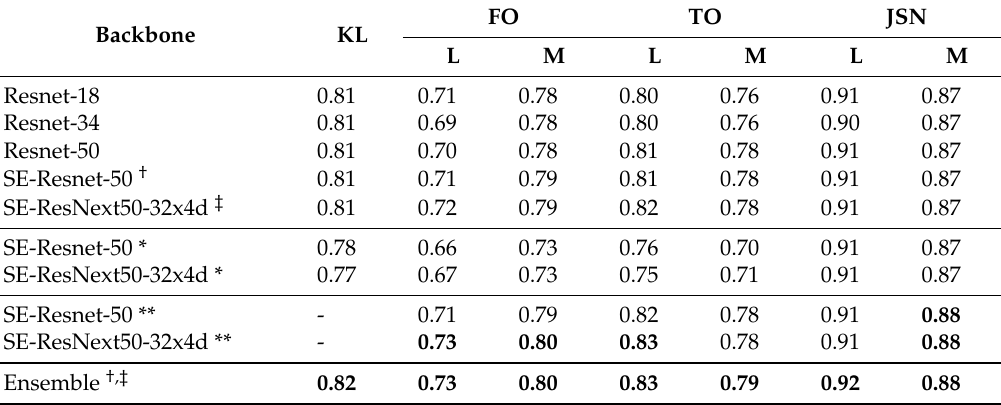
Table 2. Cross-validation results (out of fold): Cohen’s kappa coefficients for each of the trained tasks on out-of-fold sample (OAI dataset). The best results task-wise are highlighted in bold. We selected two best models for thorough evaluation: SE-Resnet-50 † and SE-ResNext50-32x4d ‡ . We trained these models from scratch (*) and also with transfer learning, but without the KL-grade (**). Finally, in the last row, we show the results for the ensembling of these models. L and M indicate lateral and medial compartments, respectively. FO and TO indicate femoral and tibial osteophytes and JSN indicates joint space narrowing, respectively. KL indicates the Kellgren–Lawrence grade.